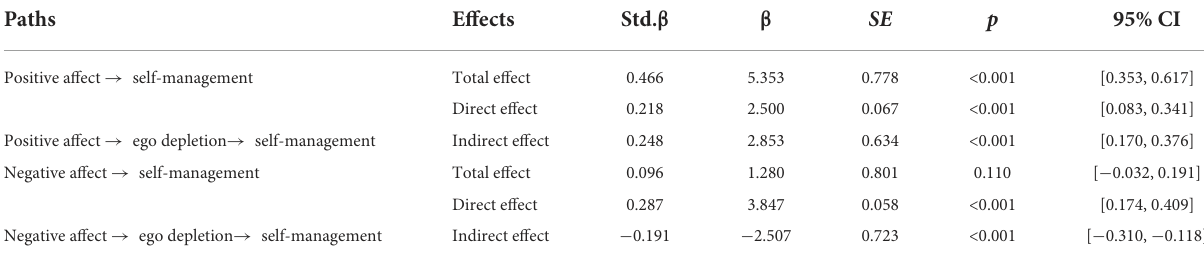
TABLE 4 Mediation analysis of ego depletion on the relationship between positive and negative affect and self-management ( n = 383). Paths